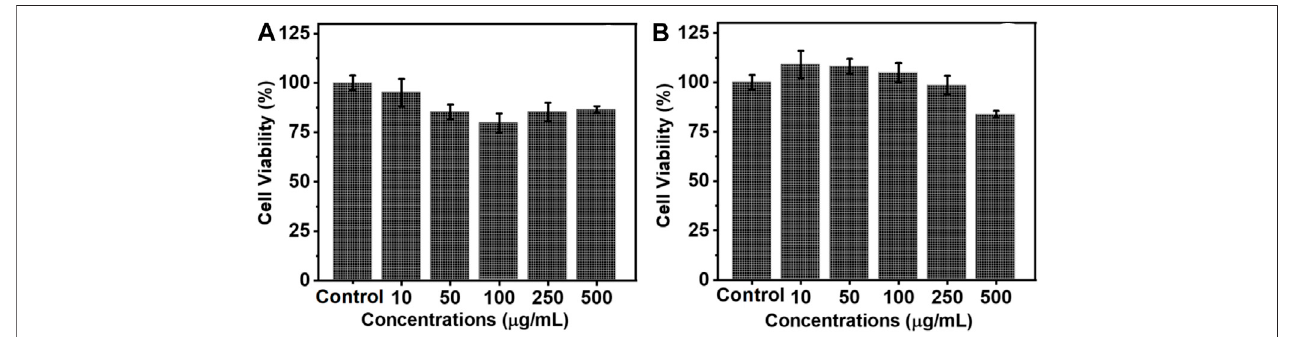
FIGURE 7 | Histogram depicting the cell viability of ovarian cancer cells (A2780) on incubation with varying concentrations of ligand free NaYF 4 :Yb/Er UCNPs after (A) 12 and (B) 24 h.